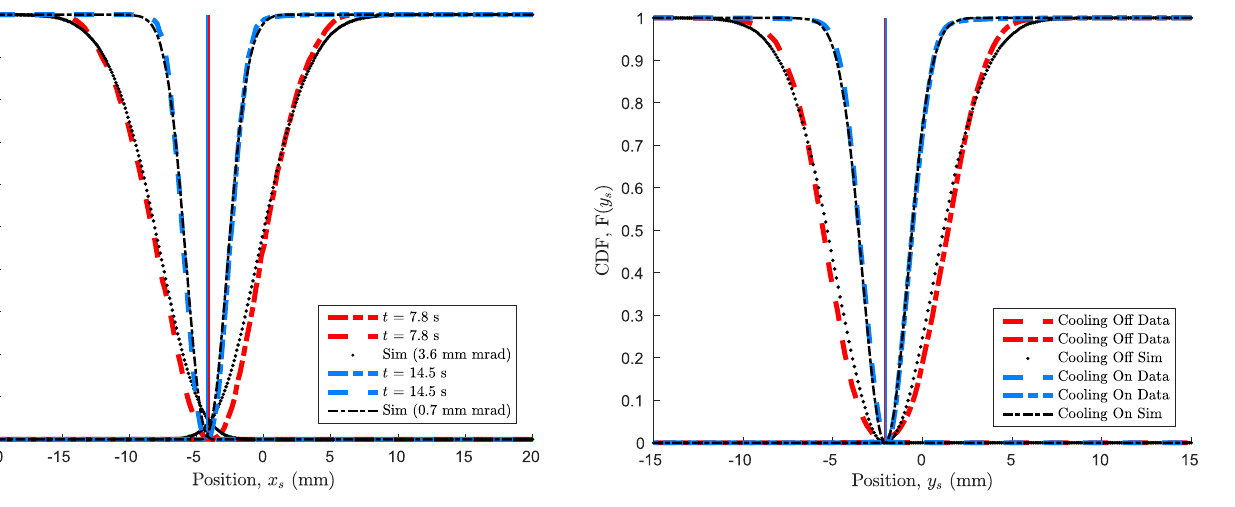
FIG. 6. CDFs produced from vertical scraper measurements at 100 keV with overlaying Gaussian distributions generated from